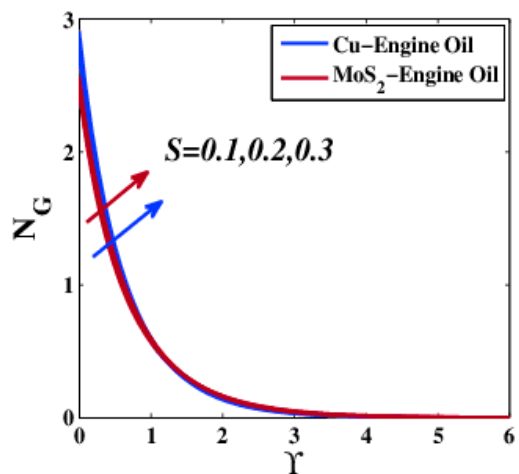
Figure 26. Entropy generation variation 𝑁 (cid:3008) under the influence of 𝑆 > 0 .